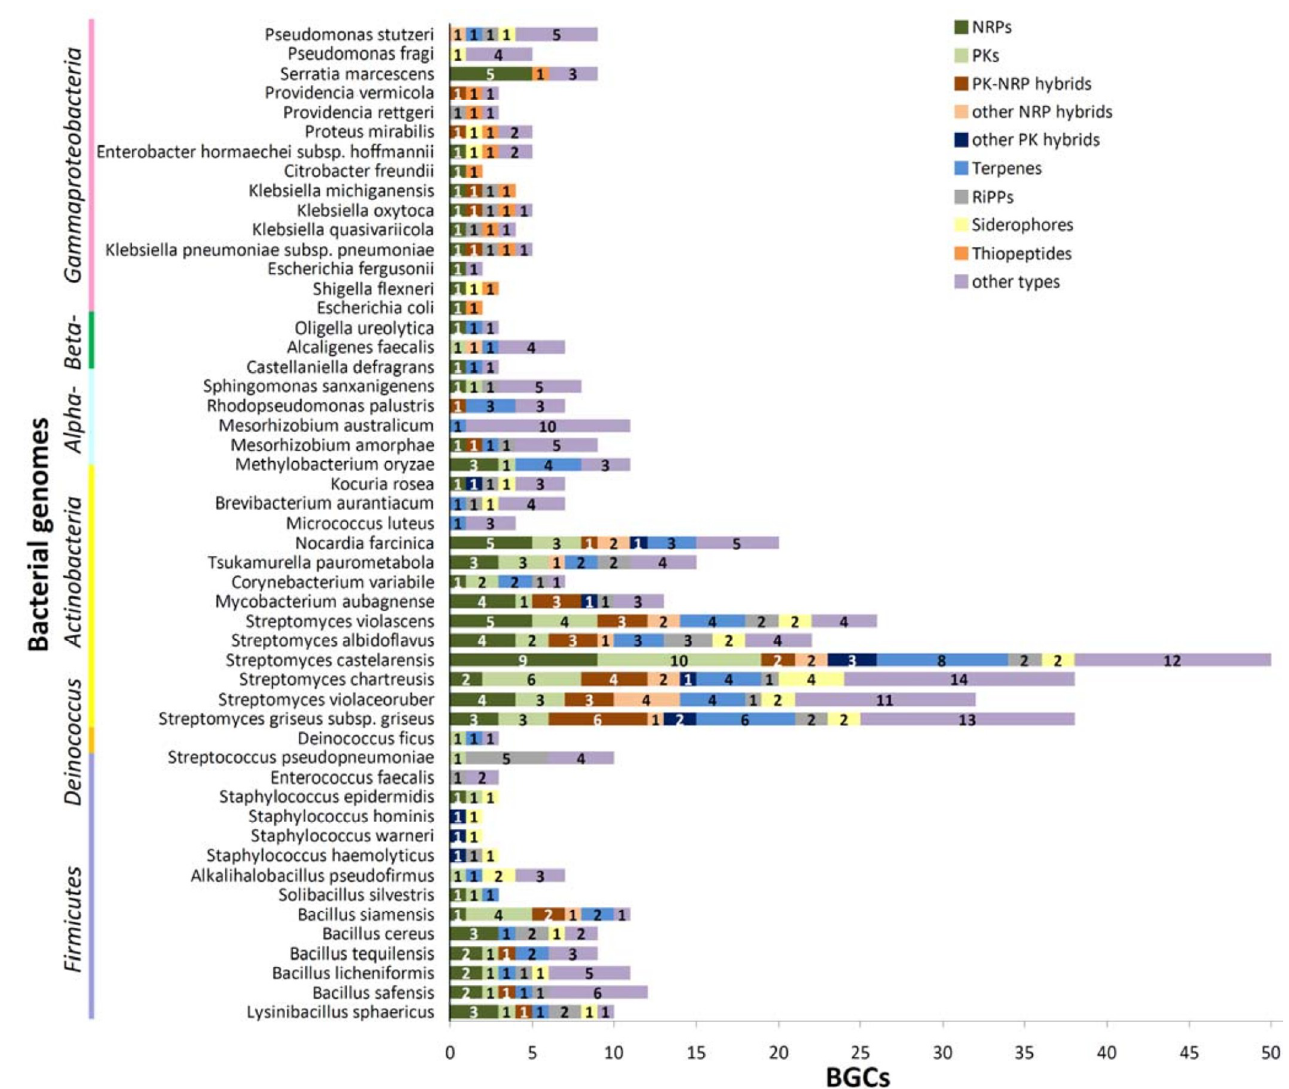
Fig 3. Distribution of biosynthetic gene clusters (BGCs) predicted in complete sequenced genomes of bacterial species represented in the collection. The graph illustrates the distribution of clusters for non-ribosomal peptides (NRPs), polyketides (PKs), PK-NRP hybrids, other NRP or PK hybrids, terpenes, ribosomally synthesized and post-translationally modified peptides (RiPPs), siderophores, thiopeptides, or "other types".